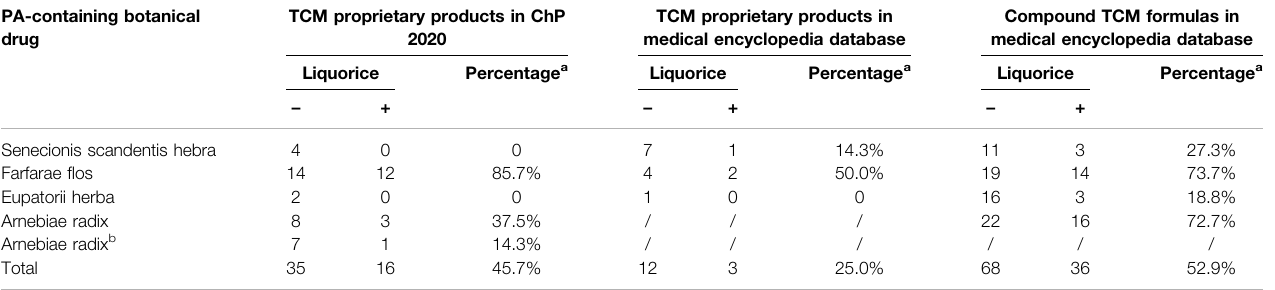
TABLE 1 | Percentage of liquorice in PA-containing TCM proprietary products and Compound TCM formulas. PA-containing botanical